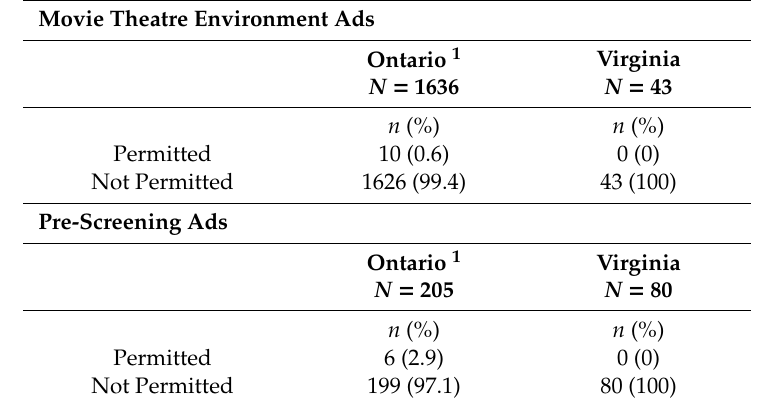
Table 2. Healthfulness of food advertisements located in the movie theatre environment and before the screening of children’s movies in Ontario and Virginia in February–May 2019 according to the WHO European Nutrient Profile Model